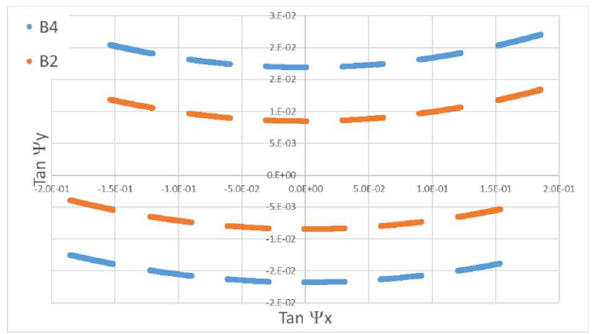
Figure 7 : S2B lines of sight for B2 and B4 bands. A typical optical distortion is